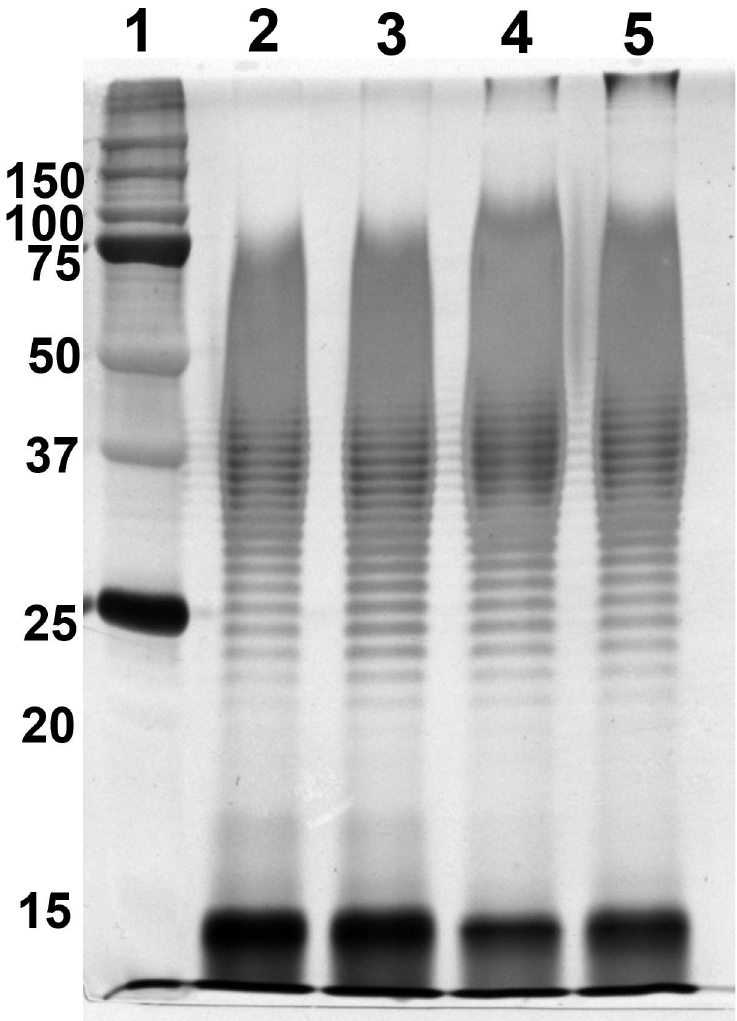
Fig 7. Purified LPS from B . pseudomallei isolates K96243, 1026b, 153 and 164. LPS was purified by a modified hot phenol-water extraction method. Five micrograms of LPS was run by SDS-PAGE electrophoresis followed by silver staining. Lane 1 was a protein marker (number at the left are masses in kilodaltons). Lanes 2–5 were the purified LPS of B . pseudomallei strains K96243, 1026b, 153 and 164,